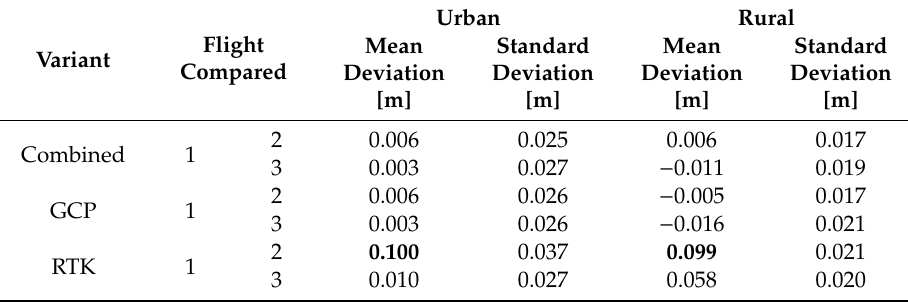
Table 10. Mutual comparison of the calculation